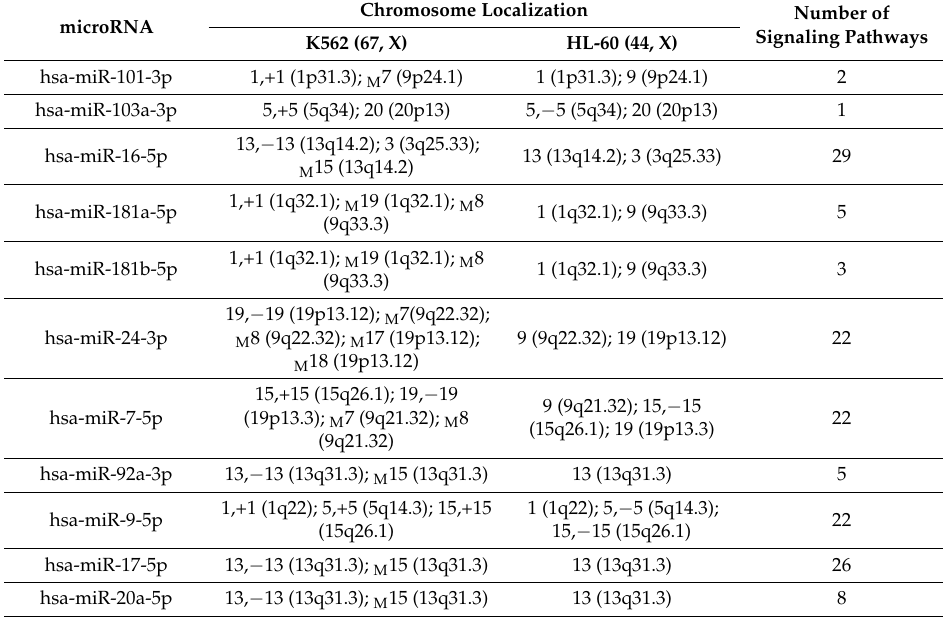
Table 1. Chromosome localization of microRNAs involved into post-transcriptional regulation of gene expression and included in signaling pathways with the log2(SNE IR /SNE C ) values higher or lower than